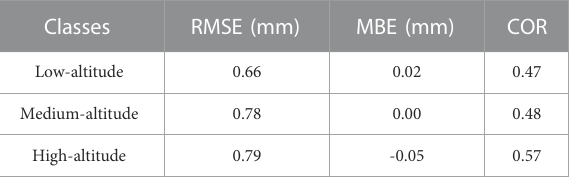
TABLE2RMSE,MBE,andCORoftheLSTM-RNmodelsatdifferentaltitudes.